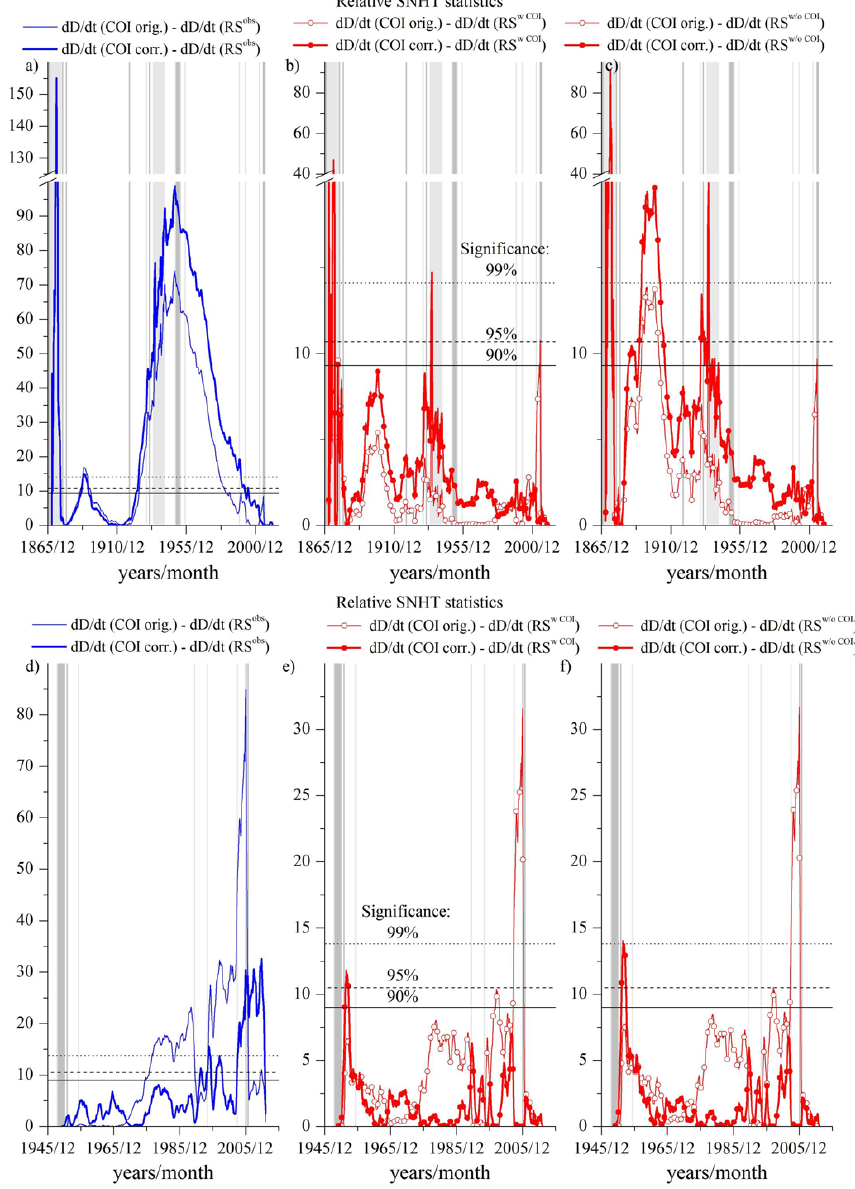
Fig. 11. (a–c) SNHT statistics for series of differences between first derivatives of COI (y2y d D/ d t ) and reference series (RS obs – D – left panel, RS w COI – D and RS w/o COI – D – middle and right panels, respectively). (d–f) Same but for the period from 1951 to 2012. Significance levels are shown by horizontal lines. Results for original series are shown by thin lines, and results for corrected series are shown by thick lines. Vertical lines mark periods of possible homogeneity breaks for COI data (see Table